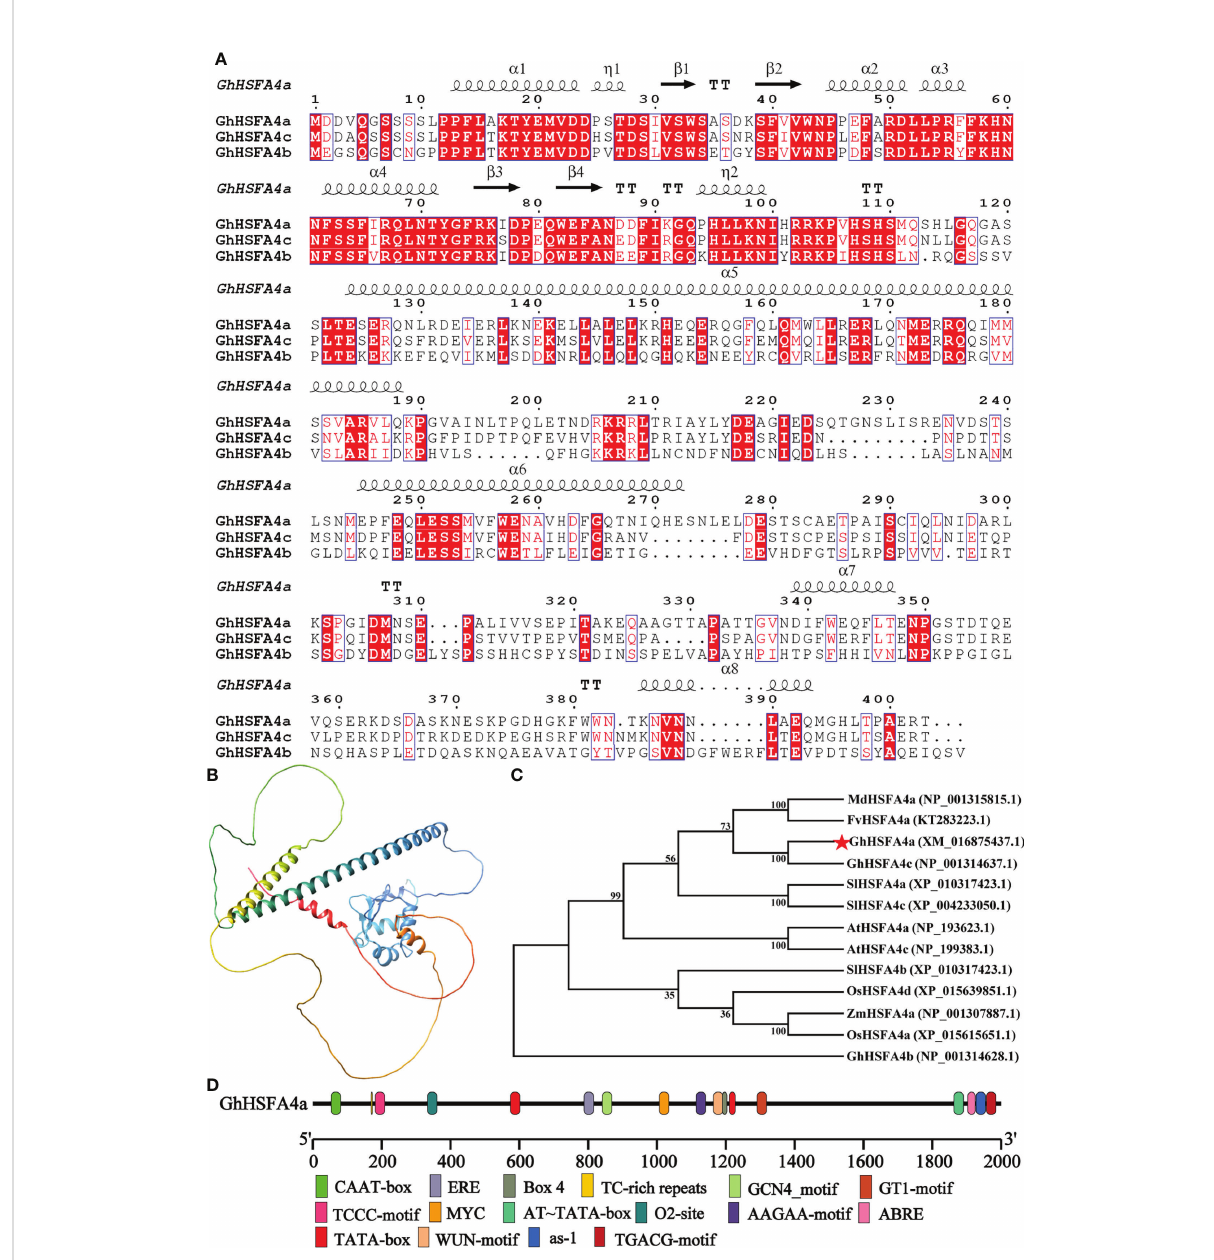
FIGURE 1 Structural characteristics of GhHSFA4a. (A) Alignment of GhHSFA4a, GhHSFA4b, GhHSFA4c proteins. (B) Three-dimensional GhHSFA4a model. (C) Phylogenetic tree of HSFA4 proteins from G.hirsutum (Gh), Solanum lycopersicum (SI), A. thaliana (At), Fragaria vesca (Fv), Malus domestica (Md), Oryza sativa (Os), and Zea mays (Zm). (D) Analysis of cis -acting element of the GhHSFA4a promoter